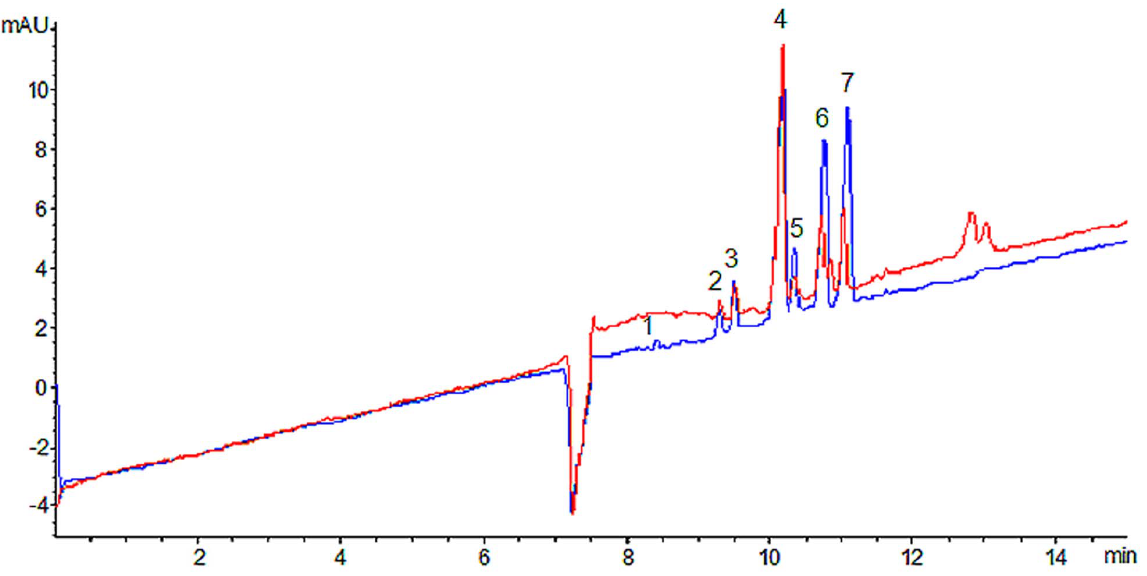
Figure 4. Capillary electropherograms of Reduning injection: Reduning injection (blue) and on-line mixed with DPPH (red) (n=3). Peaks: 1= caffeic acid, 2= isochlorogenic acid A, 3= isochlorogenic acid C, 4= chlorogenic acid, 5= isochlorogenic acid B, 6= neochlorogenic acid, 7= cryptochlorogenic acid. Experimental conditions: 50 m m i.d. 6 375 m m o.d. 6 60.5 cm length (52 cm effective length), uncoated; 20 mM NaH 2 PO 4 (pH 4.2) - 10 mM b -CD - 5% (v/v) acetonitrile, voltage, 25 kV; temperature, 22 u C; detection wavelength, 325 nm; pressure injection, 50 mbar for 5 s.